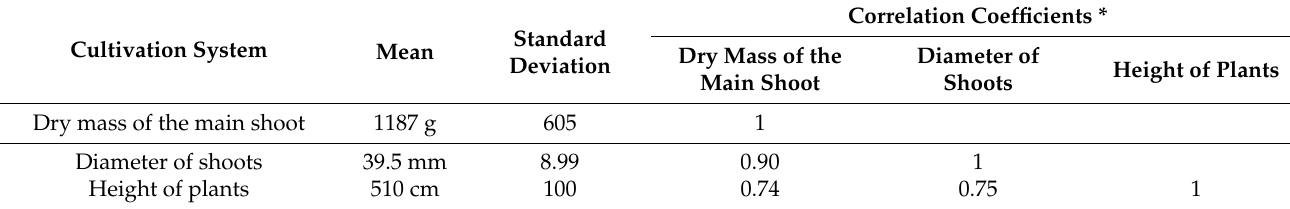
Table 7. Correlation coefficients for the analyzed traits in 2017.